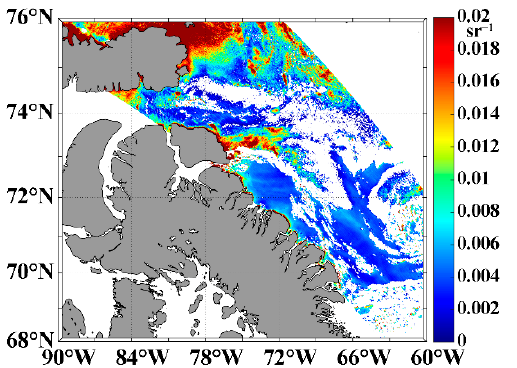
Figure 8. Rrs (443 nm) products from HY-1C-COCTS processed by the neural network atmospheric correction algorithm under a large SZA .